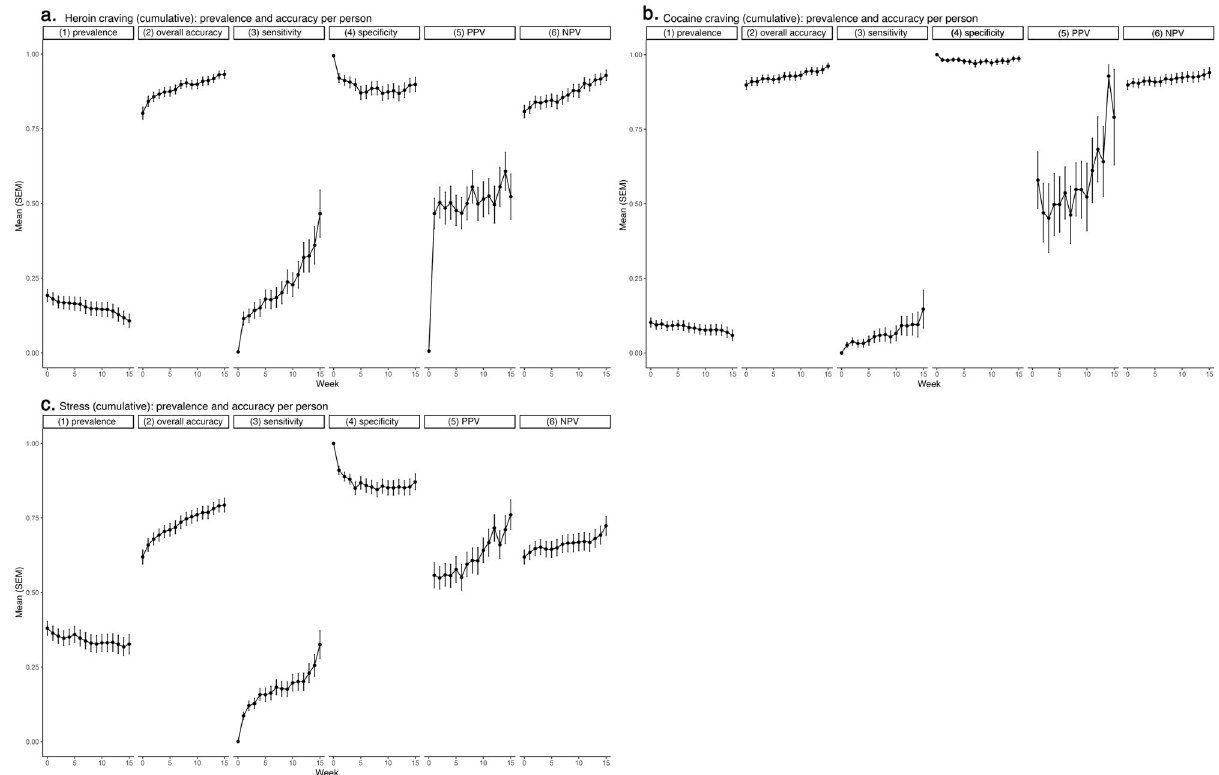
Fig. 2 Prediction accuracy (and prediction-target prevalence) per person per week, across all participants. a Heroin craving, b cocaine craving, and c stress. For some measures, not all participants could be included: PPV could not be calculated when there was no prediction of presence, and sensitivity could not be calculated when the target event did not occur. Within each panel, 6 lines of data show the following. (1) A summary of the cumulative-prevalence data from Fig. 1, N = 187. (2) Overall accuracy, N = 187. (3) Sensitivity, N = 160 (heroin), 130 (cocaine), 181 (stress). (4) Speci fi city, N = 186 (heroin), 186 (cocaine), 184 (stress). (5) Positive predictive value (PPV), N = 68 (heroin), 149 (cocaine), 118 (stress). (6) Negative predictive value (NPV), N = 187. The accuracy statistics in lines 2 – 6, though shown as time series, do not literally display weekly accuracy for any one participant moving through time. Each time point represents a separate scenario. Run 0 shows accuracy when the model is run “ off the shelf ” for each participant, using other participants ’ data to predict all 16 weeks of responses (in 90-min segments) for that participant. Run 1 shows accuracy when the model additionally includes one week of data from the target participant, predicting his or her fi nal 15 weeks of responses (in 90-min segments). Run 2 shows accuracy when the model includes two weeks of data from the target participant, predicting his or her fi nal 14 weeks of responses (in 90-min segments) — and so